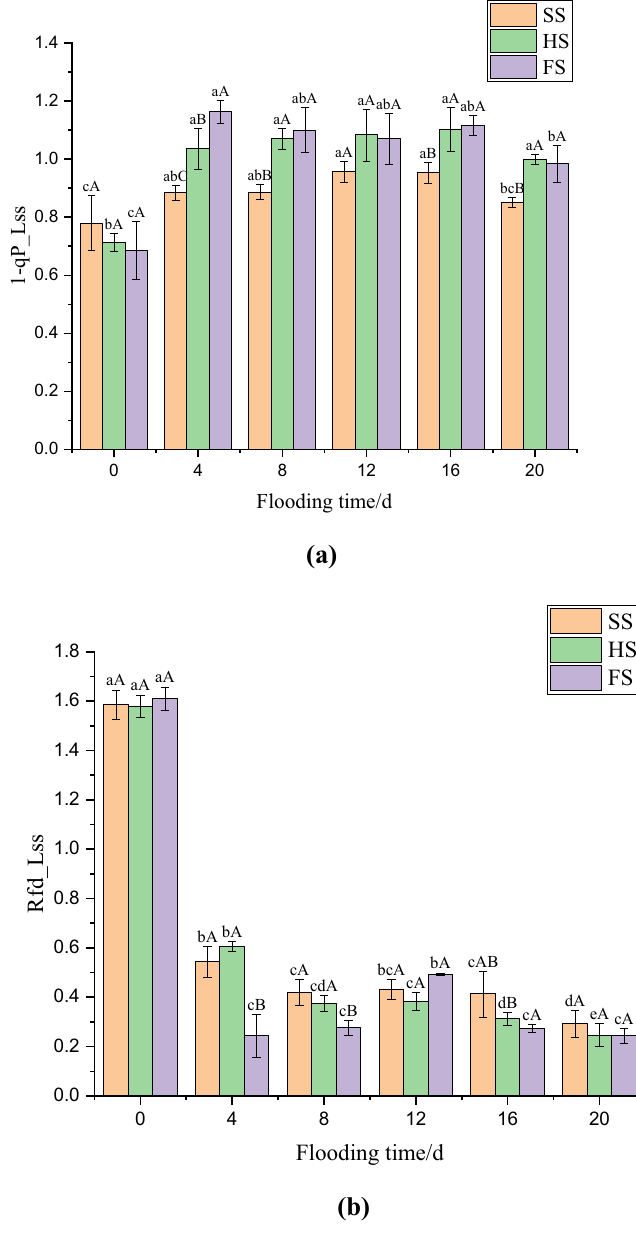
Figure 4. Effect of submergence stress on 1-qP - Lss and Rfd - Lss values in Morus alba. Different uppercase letters indicate that the means of the different groups at the same time are significantly different ( p < 0.05), and different lowercase letters indicate that the means of the same group at different times are significantly different ( p < 0.05). This figure was drawn using Origin Pro 2021 v.